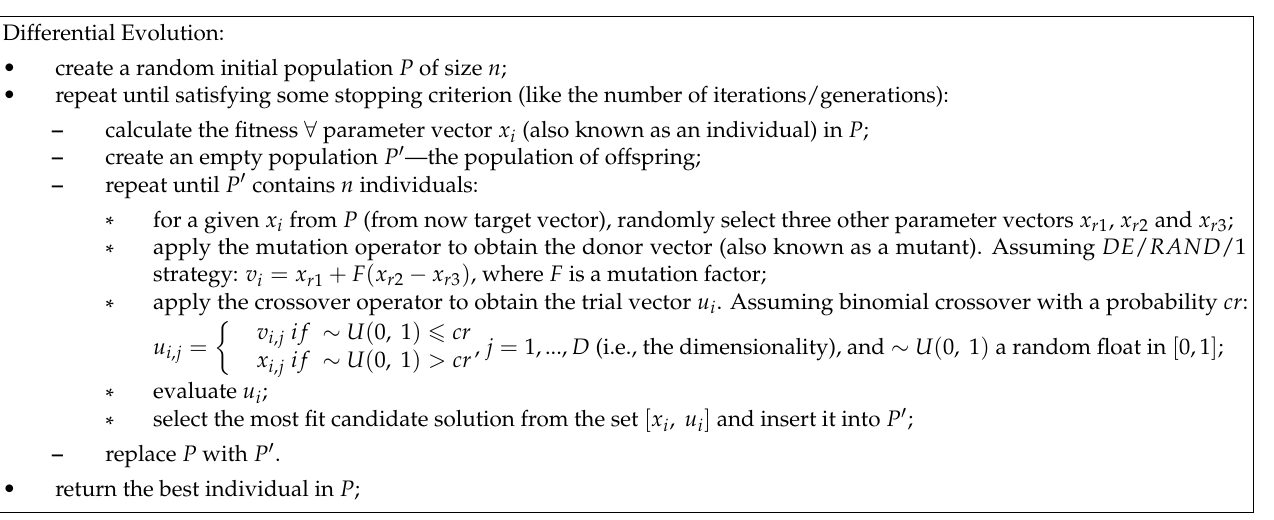
Figure 7. Procedural steps of differential